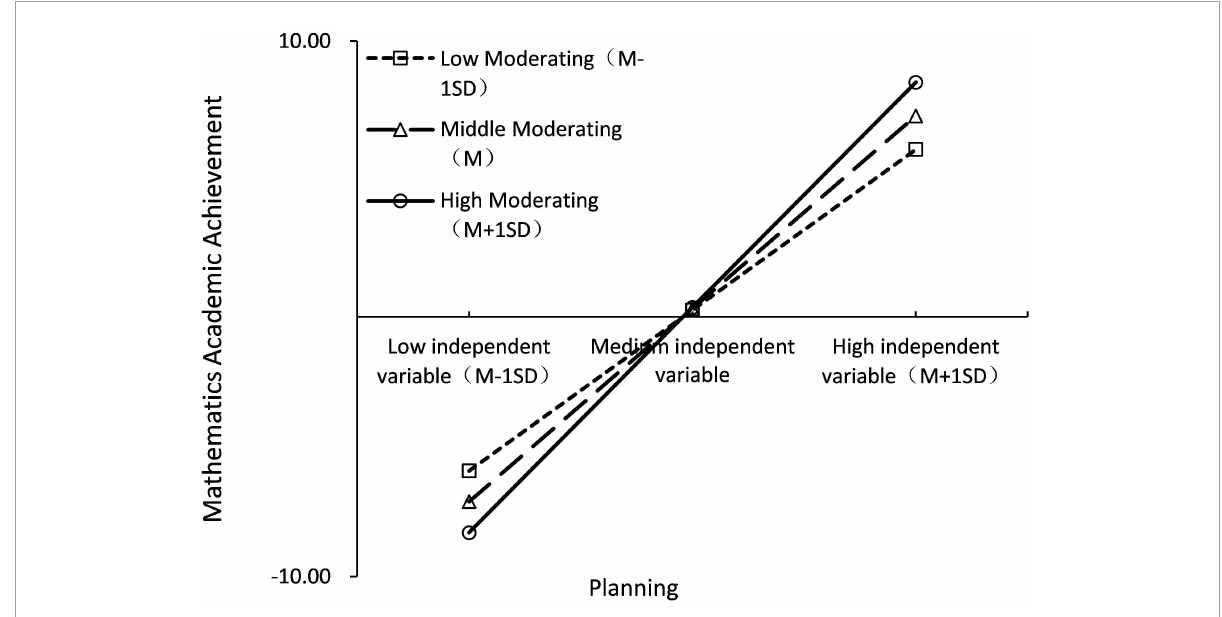
FIGURE6 Simple slope test (mathematics academic